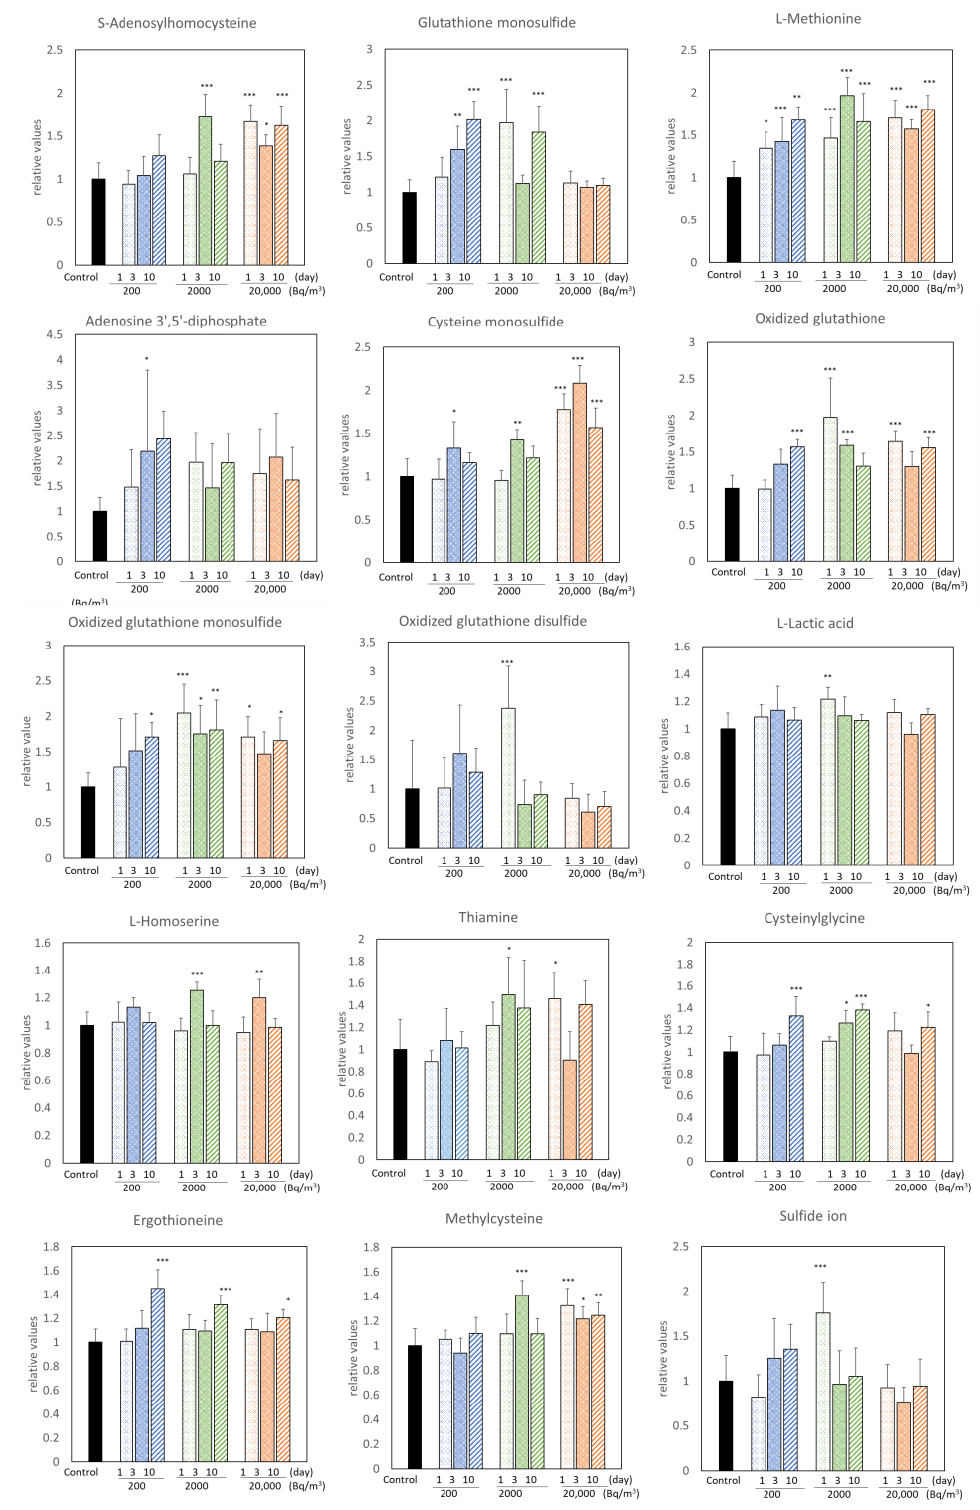
Figure 1. Metabolites significantly increased by radon inhalation. The number of mice per experimental point is six. All quantitative data are expressed as mean ± SD. * p < 0.05, ** p < 0.01, *** p < 0.001. vs. control.